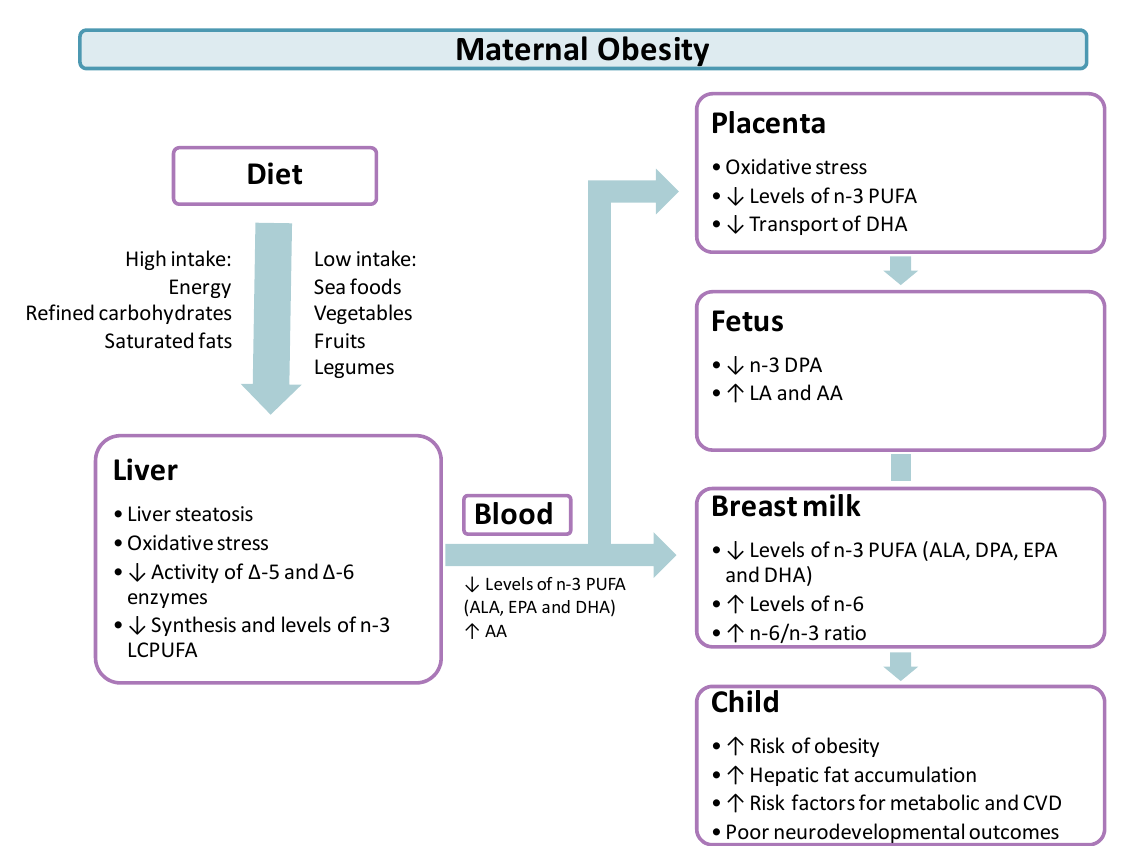
Figure 2. Impact of maternal obesity on the metabolism of n -3 and n -6 LCPUFA during pregnancy and lactation. An unhealthy diet, commonly associated with obesity, along with modifications in FA metabolism in the maternal liver, leads to low circulating levels of n -3 PUFA and elevated circulating levels of n -6 PUFA. These modifications are also present in the placenta, fetus, breast milk, and, consequently, in the child. LCPUFA, long chain polyunsaturated fatty acid; PUFA, polyunsaturated fatty acid; ALA, α –linolenic acid; AA, arachidonic acid; DHA, docosahexaenoic acid; DPA, docosapentaenoic acid; EPA, eicosapentaenoic acid; n -6/ n -3 ratio, total polyunsaturated fatty acid n -6/ n -3 ratio; CVD, cardiovascular disease; Delta -5 ( Δ -5) desaturase; Delta-6 ( Δ -6) desaturase.